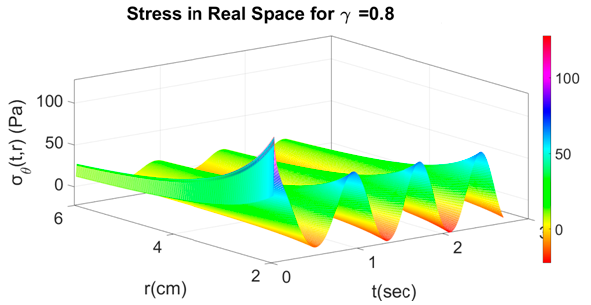
Figure 7. Distribution of the stress σ θ ( t , r ) in the initial space for γ = 0.8. Reducing the fractional order to γ = 0.7, the distribution of the radial stress σ r ( t , r ) in the initial space is shown in Figure 8, and the distribution of the tangential stress σ θ ( t , r ) in the initial space is presented in Figure 9.